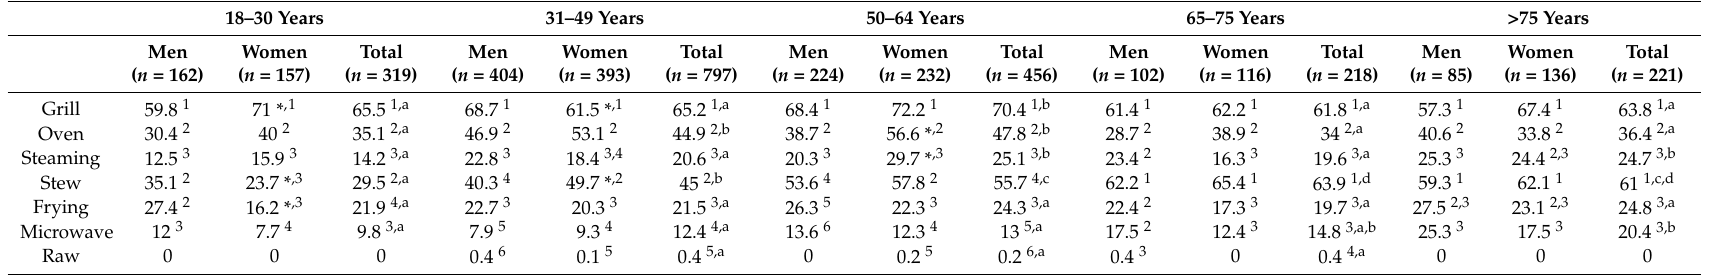
Table 4. Preferred cooking techniques by age and sex